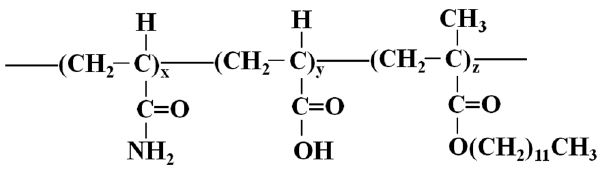
Figure 1. Molecular structure of HAWP: x = 30–100, y = 0–50, and z = 0.01–1.